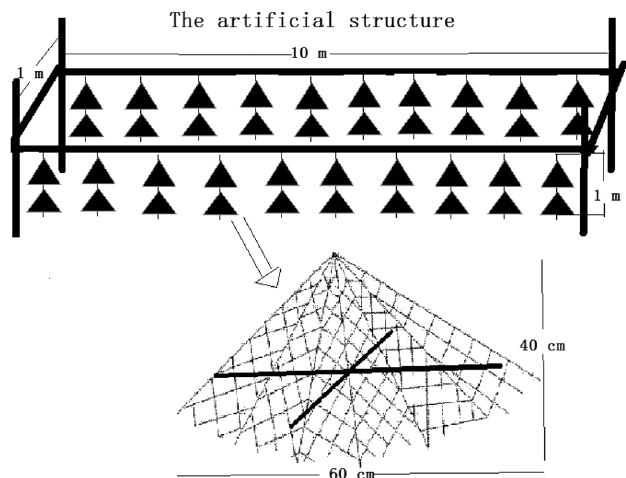
Fig. 2. The schematic diagram of arti fi cial